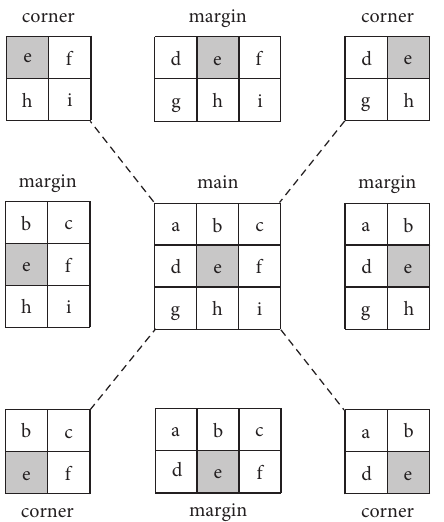
Figure 5: Neighborhood operations of a 3 × 3 input cell